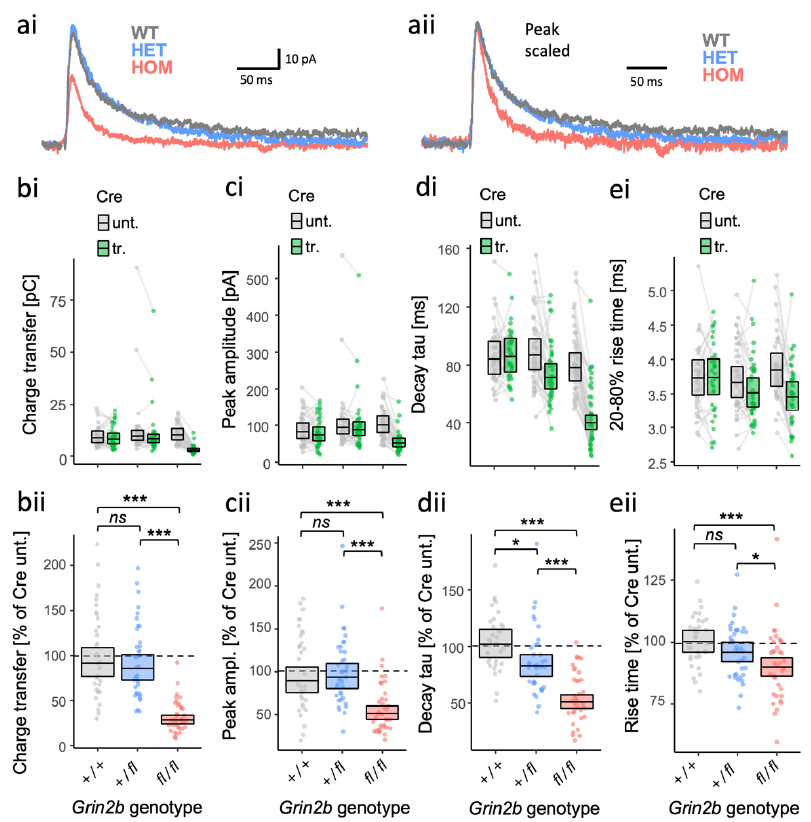
Figure 6. Dose-dependent effects of Grin2b null alleles on NMDA-EPSC kinetics. ( a ) Representative NMDA-EPSCs from Grin2b +/+ , Grin2b +/ − or Grin2b − / − neurons. NMDA-EPSC +20 mV charge transfer ( b ), peak amplitude ( c ), decay time constant ( d ) and 20–80% rise-time ( e ) in Grin2b +/+ , Grin2b +/fl or Grin2b fl/fl (untransfected) neurons and Grin2b +/+ , Grin2b +/ − or Grin2b − / − neurons (transfected, with Cre- GFP). ( b – e) (i) Data points of measurements made in individual neurons. Matched data points, for simultaneously recorded untransfected and transfected neurons are connected by a line; (ii) re- sponse ratios (transfected/untransfected) are expressed as a percentage and plotted for each pair of transfected-untransfected neurons. Crossbars in (i) and (ii) show the estimated marginal means with 95% confidence intervals backtransformed from the fitted linear mixed models (Figures S1.12– S1.15). Post hoc pairwise comparisons were made according to the Westfall stepwise procedure. Standardised effect sizes ( r ) for comparisons of each genotype with WT for response ratios, for het- erozygous and homozygous genotypes, respectively, were ( aiii ) for charge transfer, –0.05 and –0.69; ( biii ) for peak amplitude, +0.04 and − 0.43; ( ciii ) for decay taus, –0.24 and –0.63; and (diii) for rise- time, –0.14 and –0.33, (N = 107). ns = not significant (at α = 0.05), * = p < 0.05, *** = p < 0.001